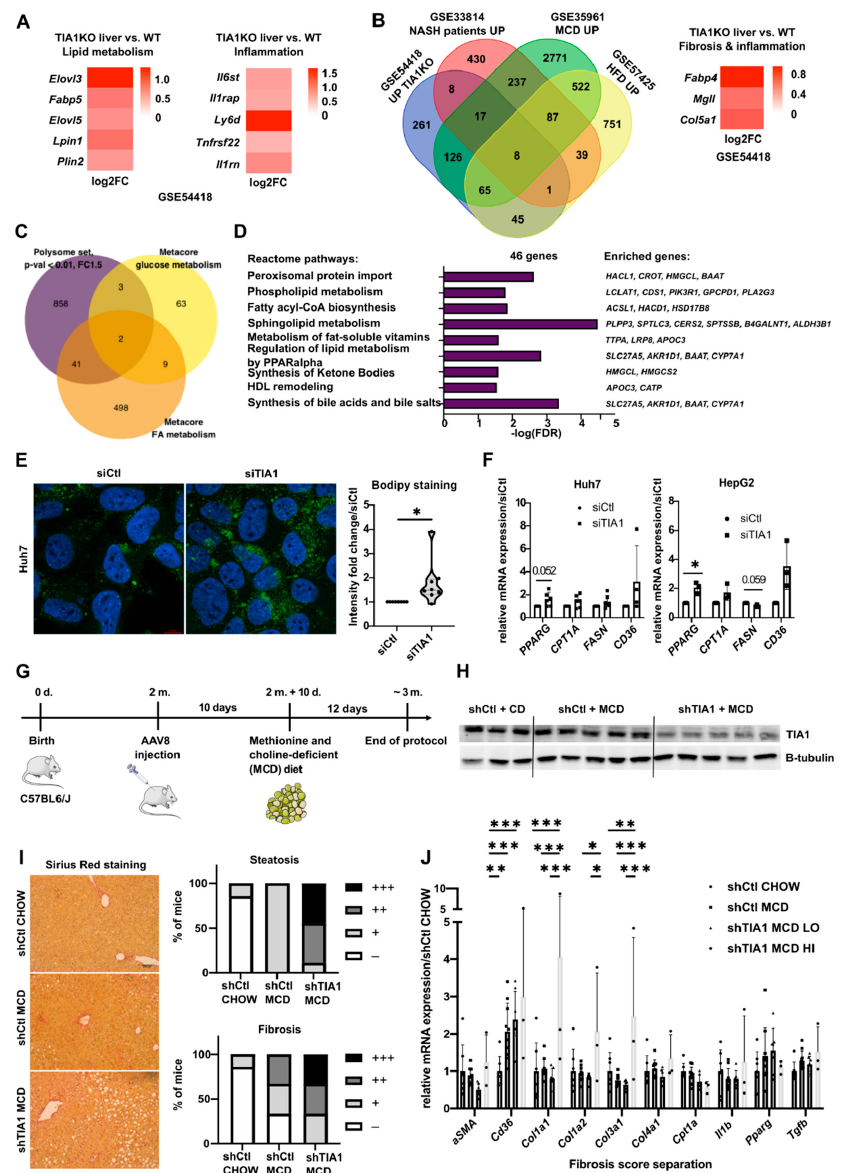
Figure 3. TIA1 prevents steatosis and fibrosis development in mice fed an MCD diet. ( A ) Expression of lipid metabolism and inflammation-associated genes in livers of TIA1KO mice (GSE54518, retrieved 1 October 2021). ( B ) Upregulated genes of livers in TIA1KO mice crossed with genes deregulated in datasets of livers in human NASH patients and mice fed an MCD diet or an HFD. ( C ) Deregulated genes from the HepG2 ± siTIA1 translatomics cross-compared with fatty acid (FA) and glucose metabolism-associated genes. ( D ) GO enrichment analysis of the 46 genes (PANTHER GO-Slim BP, FDR < 0.05). ( E ) Representative pictures and quantifications of BODIPY staining of Huh7 ± siTIA1 (n = 8: 48 h post-transfection). ( F ) Expression of genes related to fatty acid metabolism in Huh7 and HepG2 ± siTIA1 (n = 3–6: 48 h post-transfection). ( G ) Protocol of TIA1 silencing in mouse fed an MCD diet. ( H ) Western blot showing TIA1 silencing in shTIA1/shCtl mice ± MCD diet for 12 days, normalized by β -tubulin. Original blots see File S2. ( I ) Representative Sirius red stainings of livers of shTIA1/shCtl mice ± MCD diet, together with the quantifications. ( J ) Relative mRNA expression analysis in shTIA1/shCtl mice ± MCD diet. shTIA1 mice were divided based on their fibrosis score. Data were represented as mean ± SD. Unpaired t-test was used for comparison of two groups and one-way ANOVA with multiple comparisons was used for comparison of three or more groups, unless specified otherwise. * p < 0.05, ** p < 0.01 and *** p <